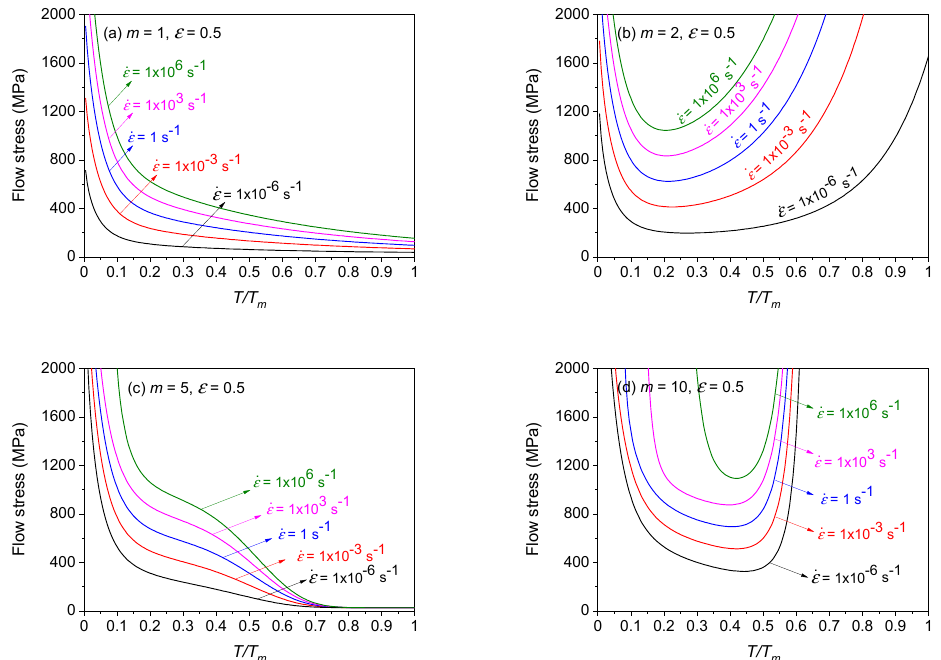
Figure 22. TBRI model-predicted flow stress (at ε = 0.5) for A508 steel with change in T / T m when ( a ) m = 1; ( b ) m = 2; ( c ) m = 5; ( d ) m = 10.